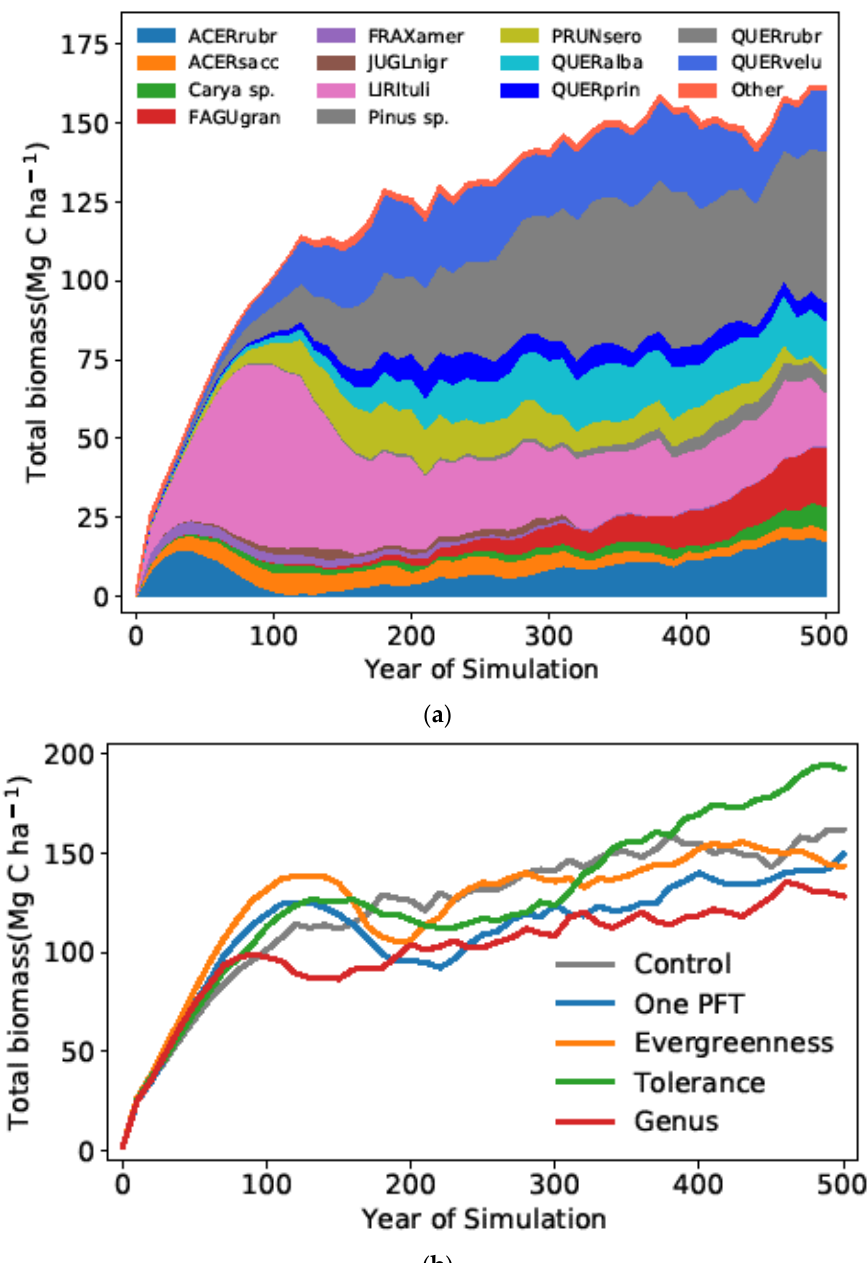
Figure 1. ( a ) Dynamics of species-specific biomass (MgCha − 1 ) averaged over 200 × 500 m − 2 plots simulated by UVAFME for 500 years. Width of each color band is the biomass of a species or group of species. The topmost line is the total biomass. Species codes are: ACERrubr (Acer rubrum); ACERsacc ( A . saccharum ); Carya sp. ( Carya cordiformes , C. glabra , C. ovata , C. tomentosa ); FAGAgran ( Fagus grandifolia ); FRAXamer ( Fraxinus americana ); JUGLnigr ( Juglans nigra ); LIRItuli ( Liriodendron tulipifera ); Pinus sp. ( Pinus echinata , P. strobus , P. virginiana ); PRUNsero ( Prunus serotina ); QUERalba ( Quercus alba ); QUERprin ( Q. prinus ); QUERrubr ( Q. rubra ), QUERvelu ( Q. velutina ); Other ( Aesculus octandra ; Cercis canadensis ; Cornus florida ; Diospyros virginiana ; Juniperus virginiana ; Liquidambar styraciflua ; Nyssa sylvatica ; Oxydendron aboreum ; Robinia pseudoacacia ; Quercus coccinea ; Sassafras albidum ; Tilia heteophylla ). ( b ) Biomass dynamics (MgCha − 1 ) for simulations with four different aggregation functions in an arithmetic mean approach against the standard species-specific